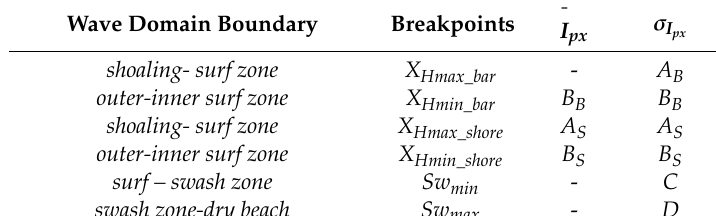
Table 2. Relation between wave transformation domain boundaries, breakpoints marked on Timestacks (see Figure 6a) and specific points identified on I px and σ I